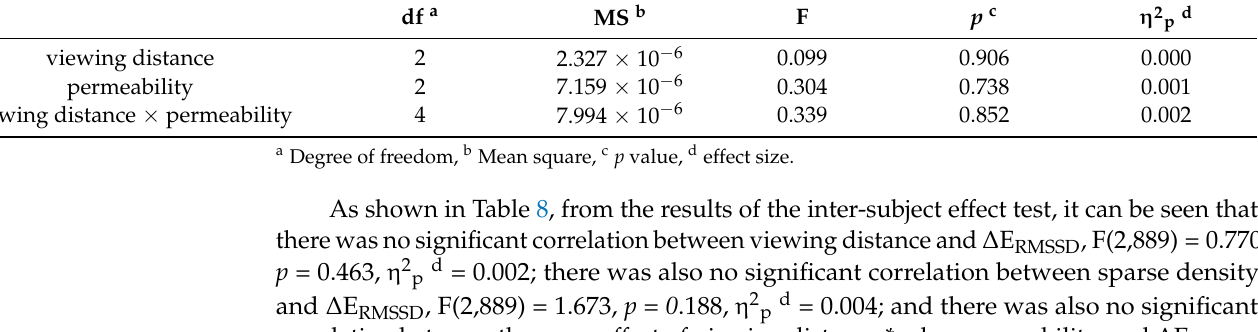
Table 7. Impacts of different viewing distances and permeability levels on (cid:52) E SPO2. df a MS b F p c η 2 p d